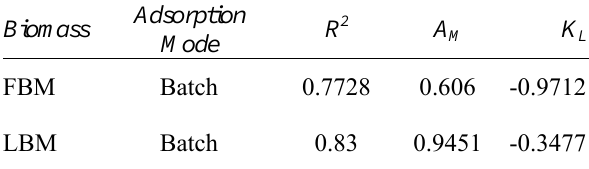
Table 2: Langmuir Adsorption constant